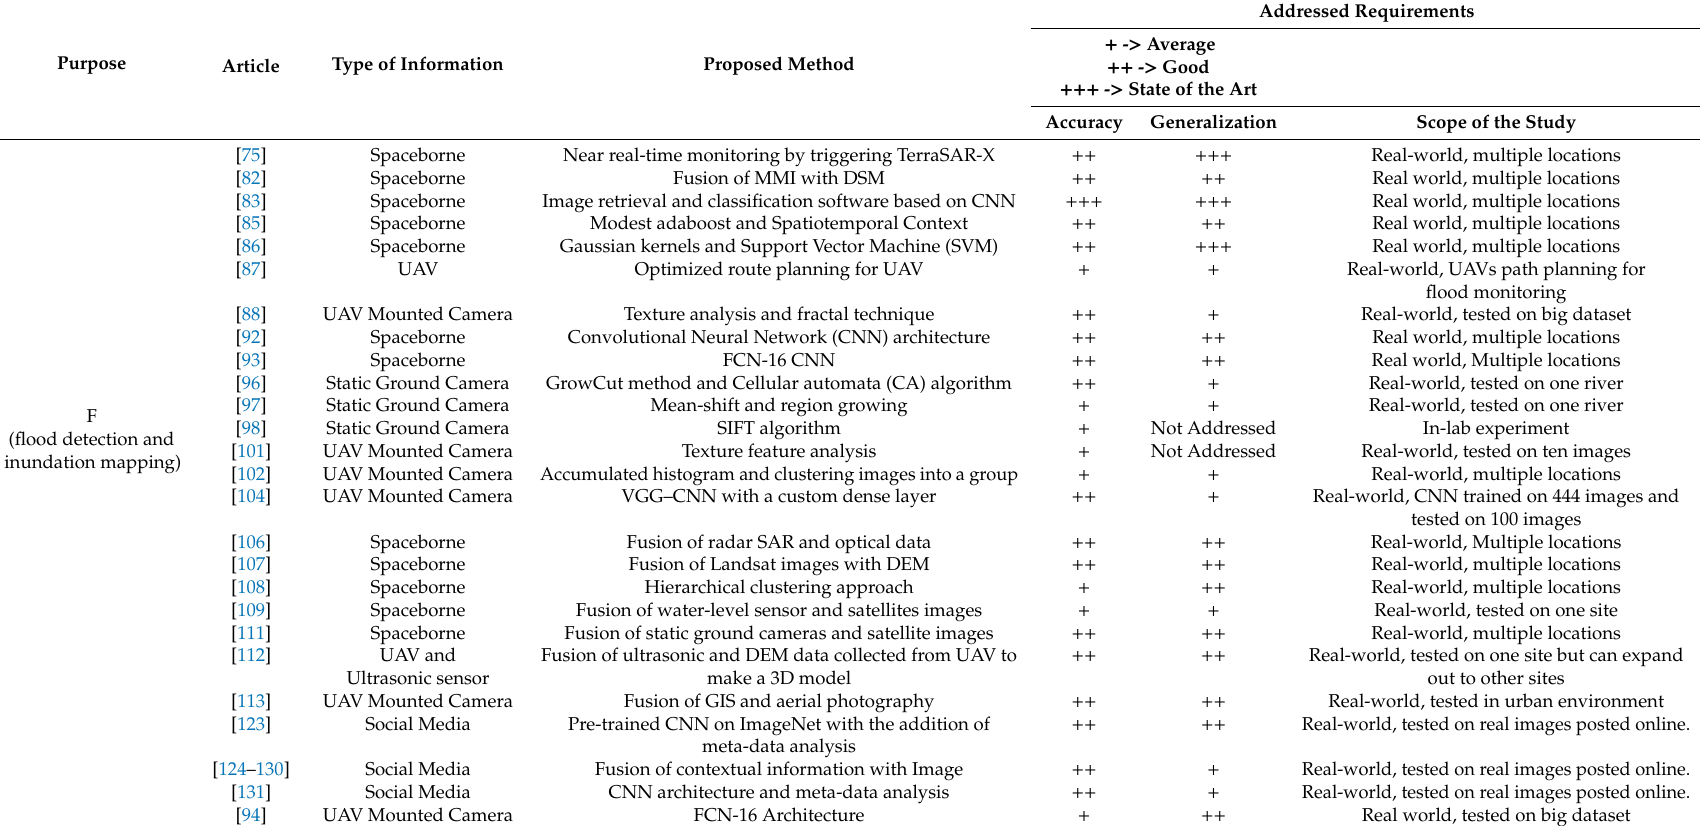
Table 9. Analysis of computer vision applications against addressed requirements: Part